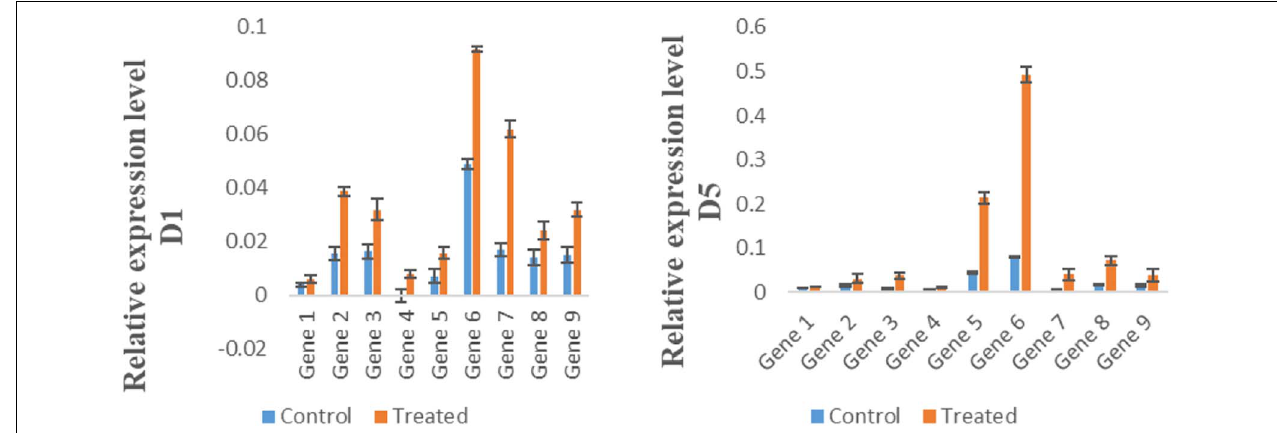
FIGURE 8 | Expression of genes in control group (CK) and Mn-treated group (WT) at day 1, day 5, and day 10. Error bars represent the standard deviation.